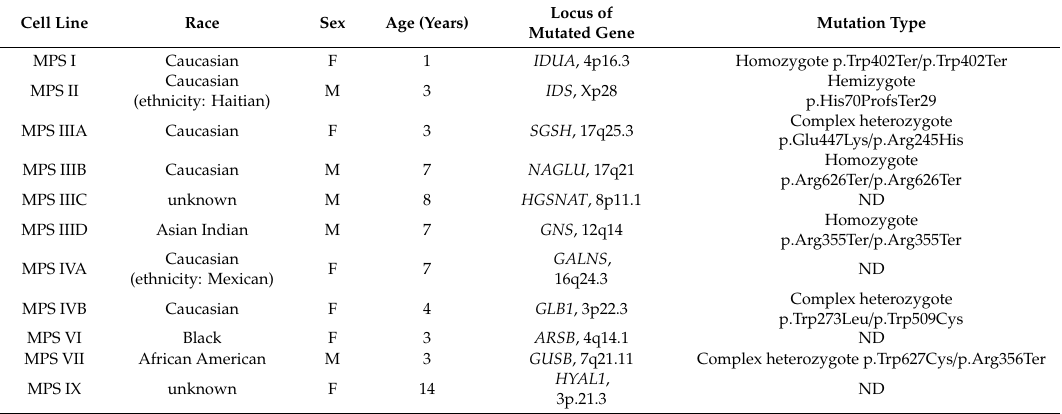
Table 2. Characteristics of cells derived from MPS patients [according to Coriell Institute